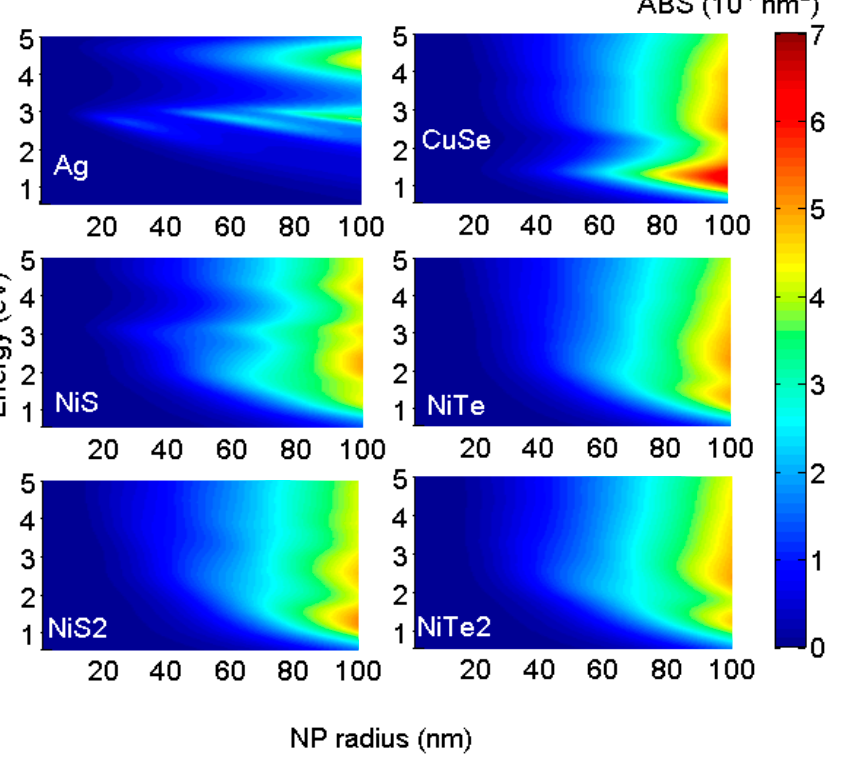
Figure 3. Distribution of absorption cross sections of different NPs function of energy and NP radius.